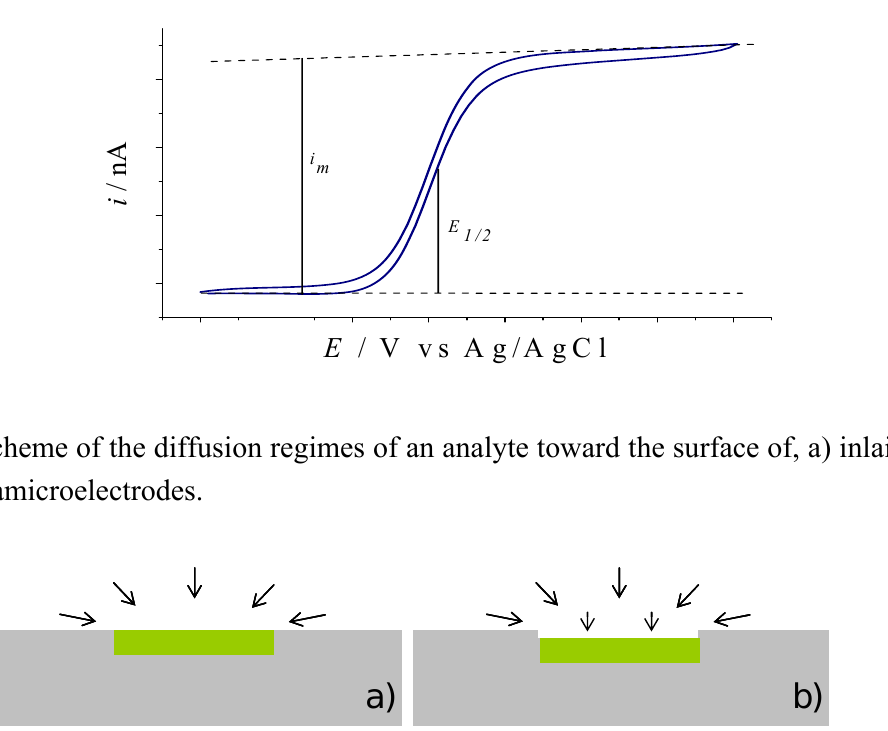
Figure 1. Typical sigmoidal signal obtained with an ultramicroelectrode array.